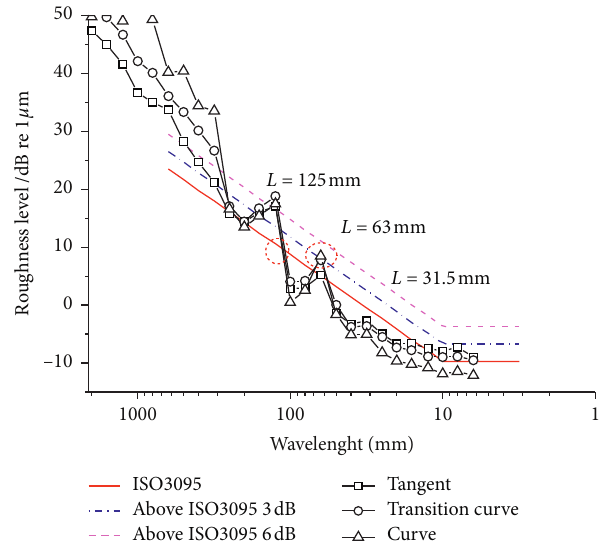
Figure 4: Roughness spectra of corrugation on high and low rails of curved